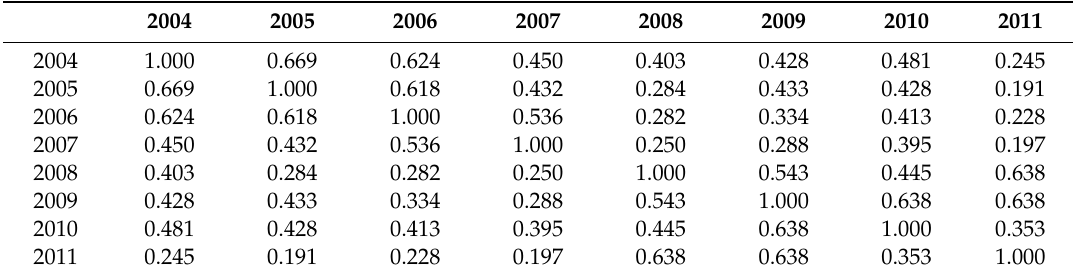
Table 3. Correlation between transaction densities in individual